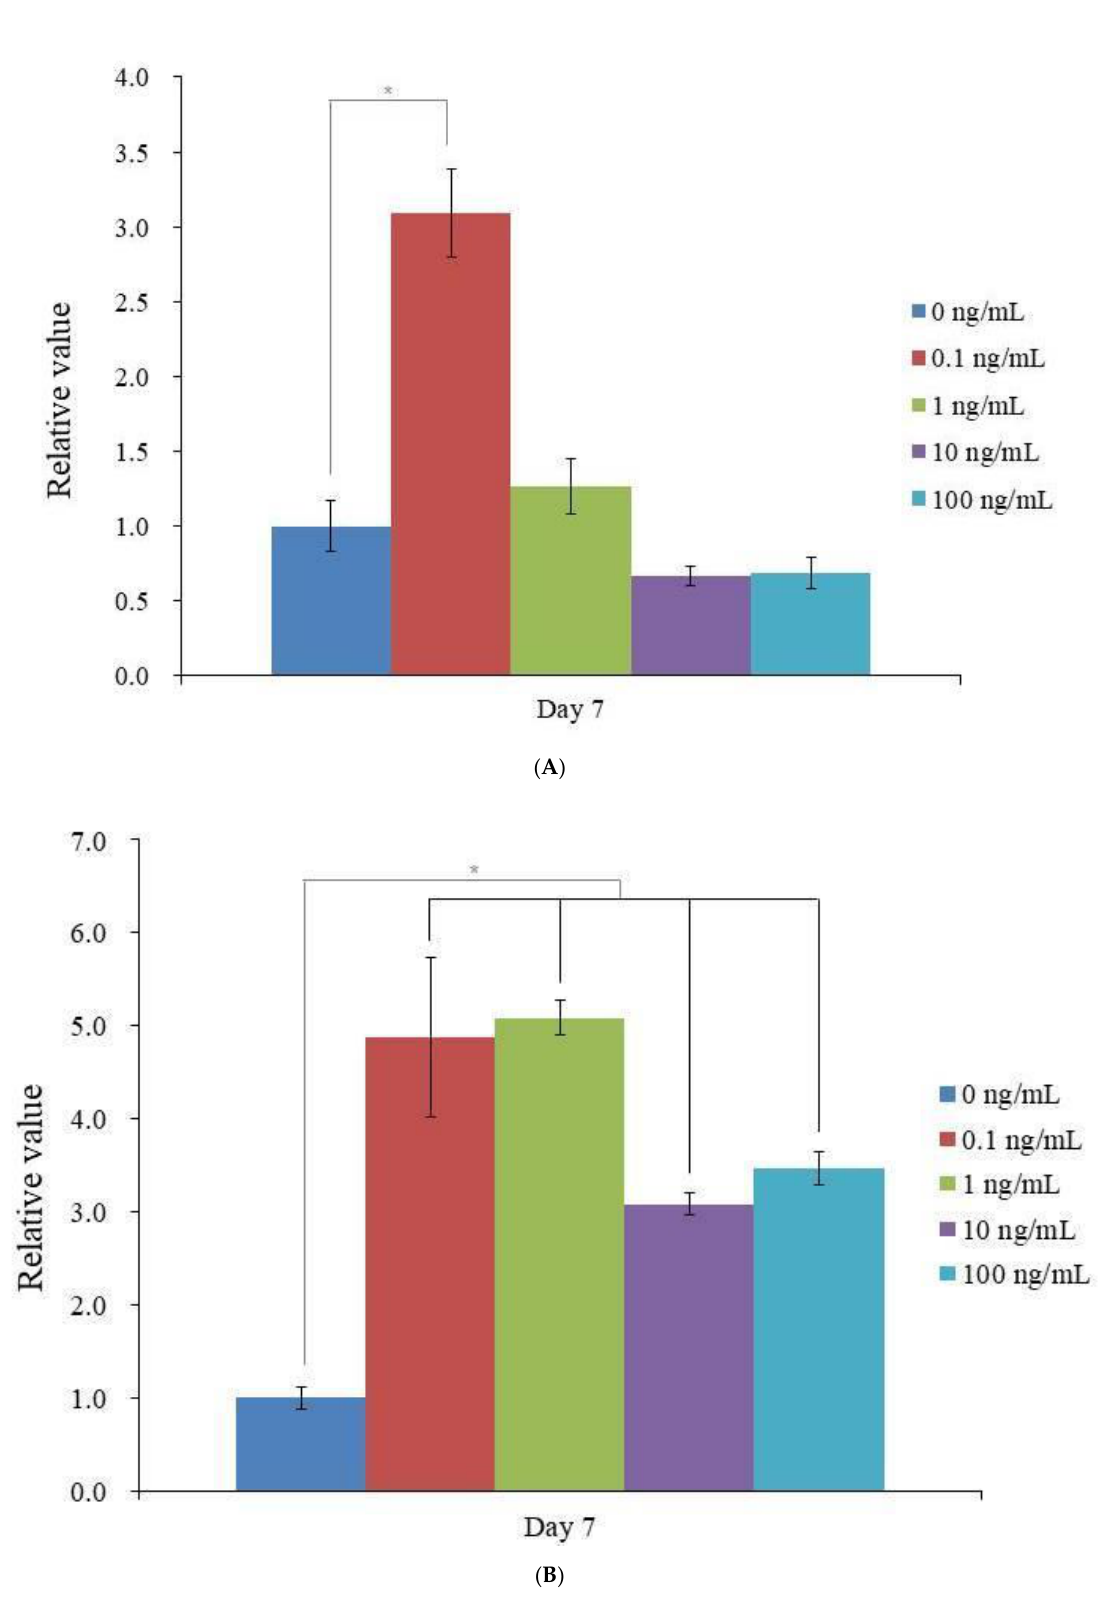
Figure 4. The quantitative expression of mRNA. ( A ). RUNX2 mRNA expression was measured in real time by a polymerase chain reaction on day 7. * p < 0.05 in comparison to day 7’s 0 ng/mL. ( B ). Measurement of COL1A1 mRNA expression by real-time polymerase chain reaction on day 7. * p < 0.05 in comparison to day 7’s 0